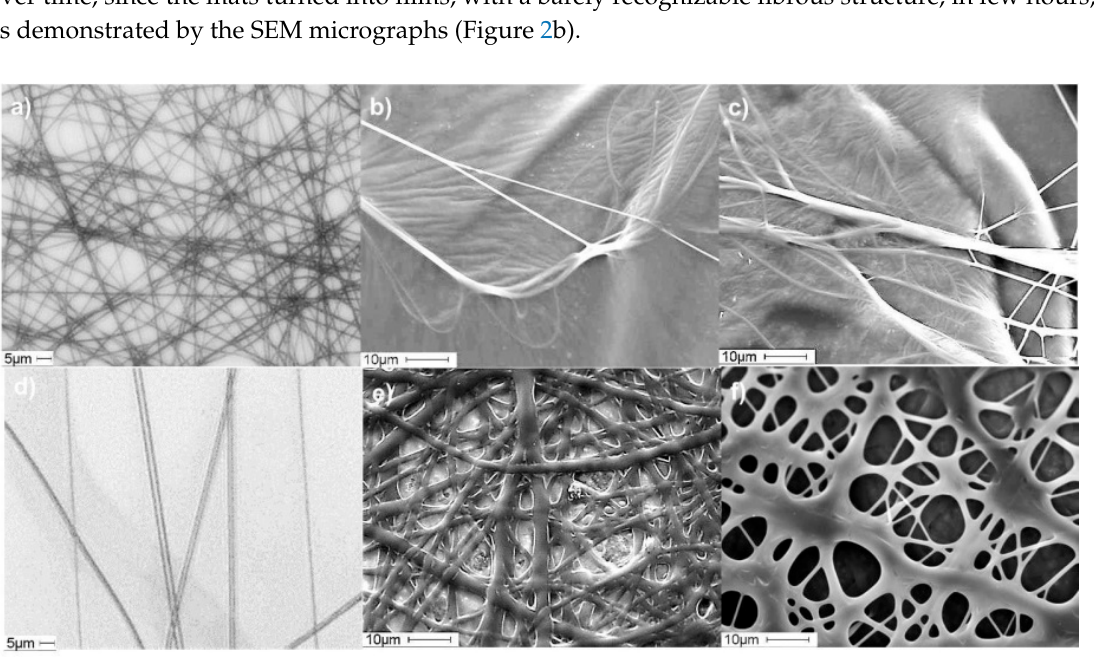
Figure 2. OM ( a , d ) and SEM images ( b , c , e , f ) of electrospun mats from FG ( a , b , c ) and FG+NaOH ( d , e , f